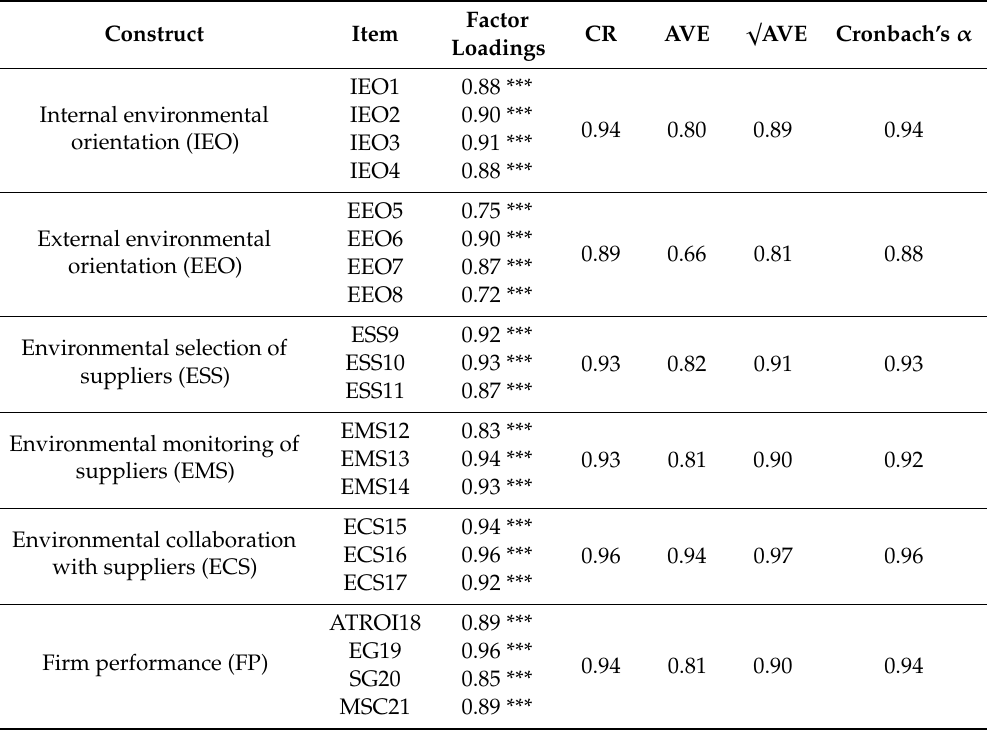
Table 5. Confirmatory factor analysis (CFA)